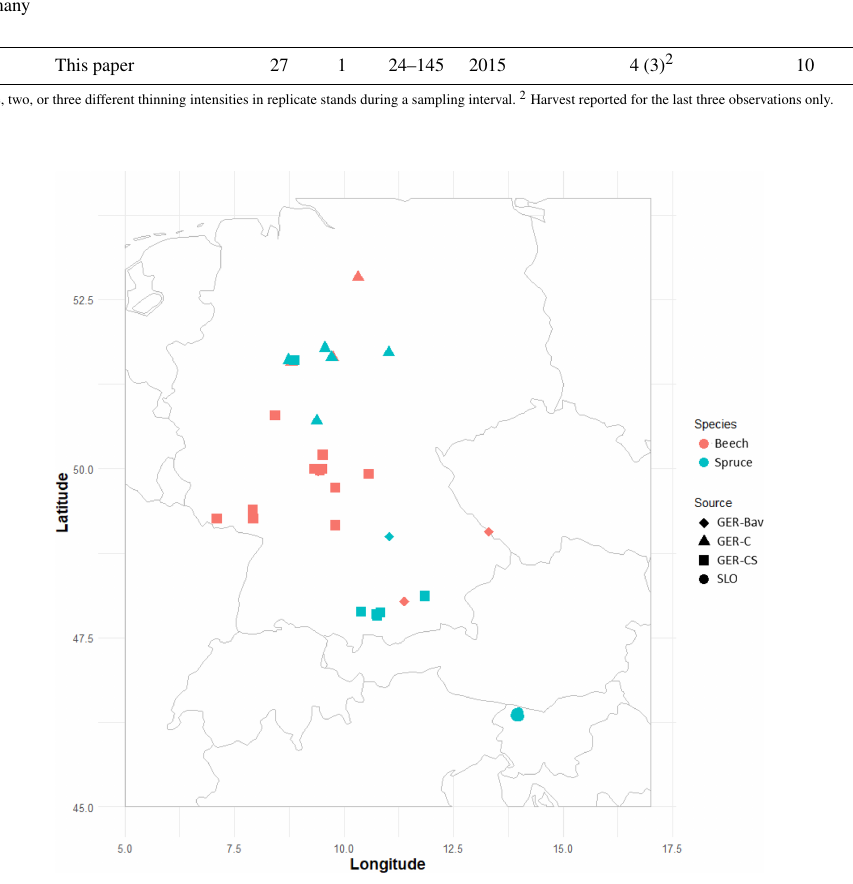
Figure D1. Location of the beech and spruce sites for the four stand